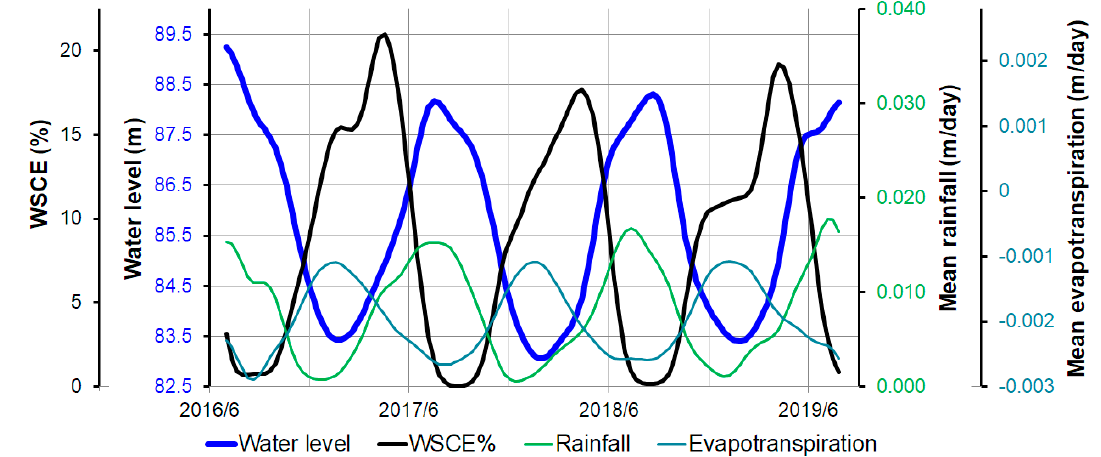
Figure 12. The time series water level of the Brahmaputra River and the WSCE%, as well as the hydrological factors, including liquid rainfall and evapotranspiration.